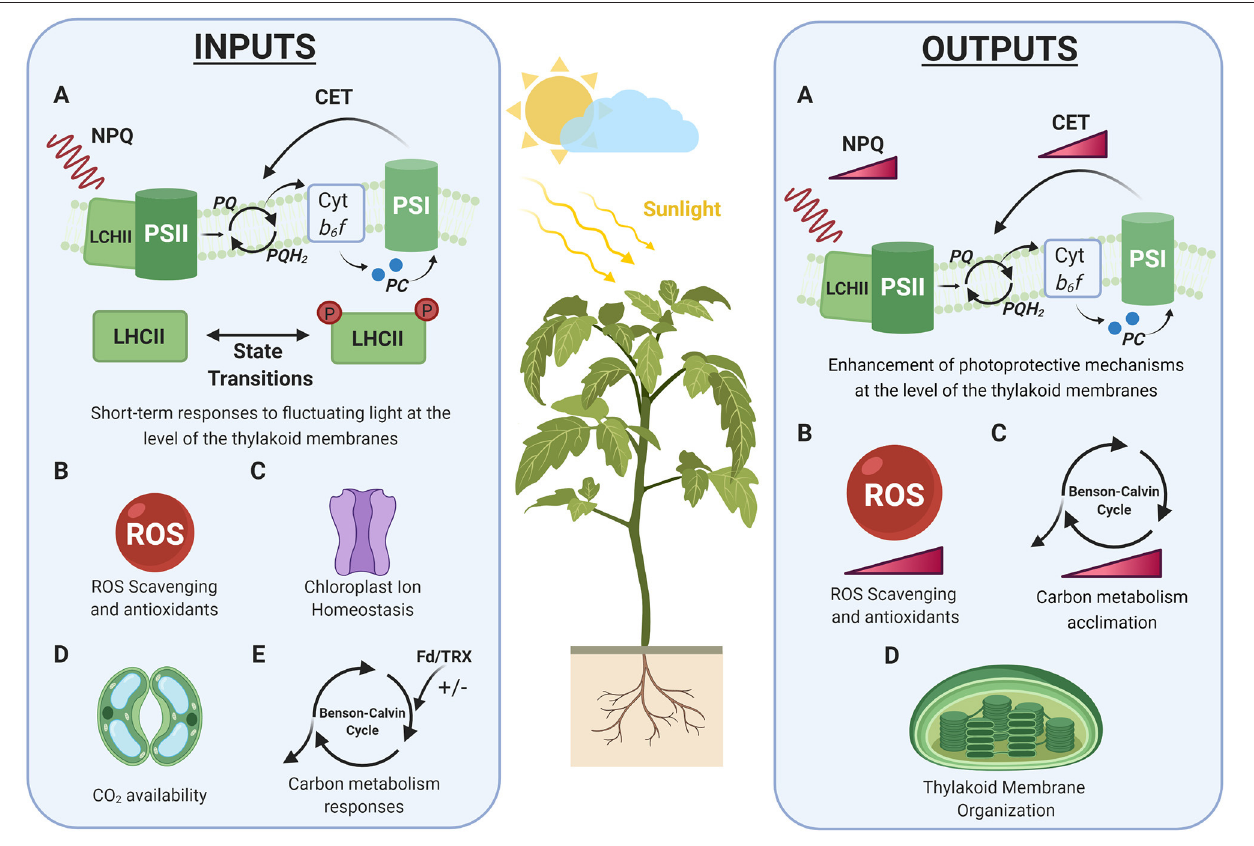
FIGURE 1 | Short and long-term responses to fluctuating light. Schematic representation of the physiological processes defined as inputs and outputs of photosynthetic acclimation to fluctuating light in plants (see sections System Inputs: Short-Term Responses to Fluctuating Light and System Outputs: Long-Term Acclimation to Fluctuating Light). Colored gradient triangles depict accumulation of ROS or intensification of a process. LHCII, Light Harvesting Complex II; PSII, Photosystem II; PSI, Photosystem I; NPQ, Non-Photochemical Quenching; CET, Cyclic Electron Transport; Cyt b 6 f , Cytochrome b 6 f ; PQ, Plastoquinone; PQH2, Plastoquinol. Created with